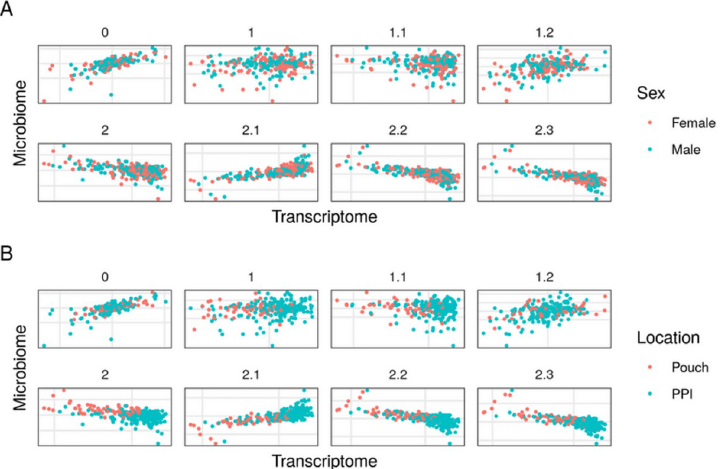
Fig 4. First dimensions of the host transcriptome and the microbiome block of models on the pouchitis dataset. Comparison of the models vis- à -vis on the pouchitis dataset by the first component of the host transcriptome and the microbiome from the HSCT CD dataset. Each point represents a sample colored by sex (A), where females are in red and males in blue, and by location (B), where the pouch is the red, and PPI is the pre-pouch ileum. The samples do not show a sex-specific pattern but on the best models the host transcriptome partially separates pouch and pre-pouch ileum